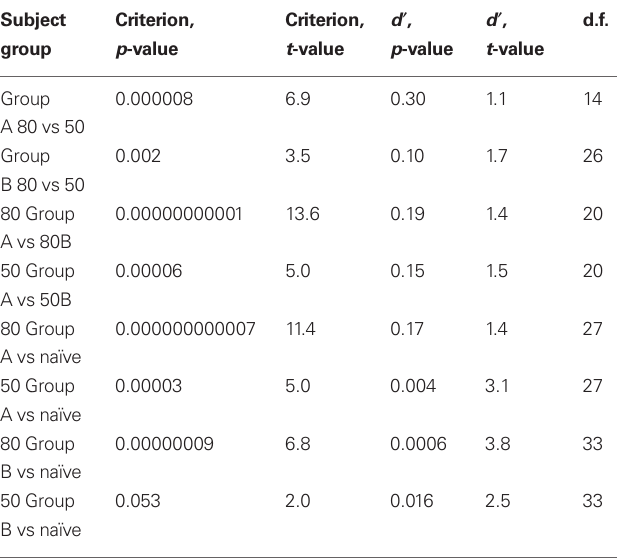
Table 2 | Criterion and d ′ differences across conditions and subject groups.